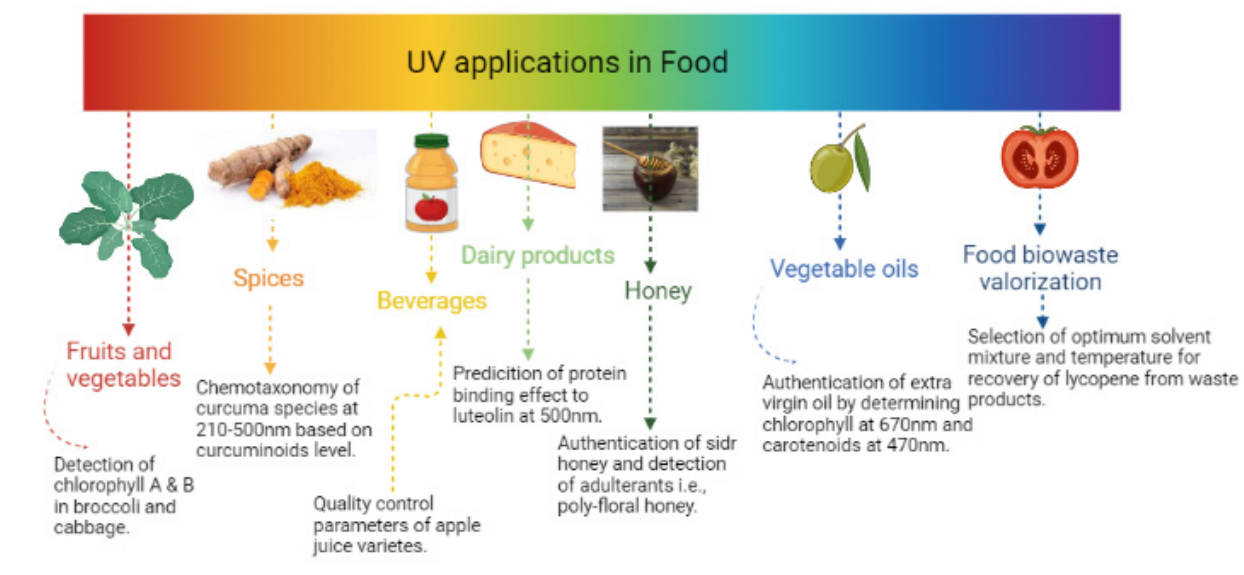
Figure 2. UV-Vis applications in different food products and food biowastes’ valorization. Table 1. List of major UV-Vis applications in the field of food production and